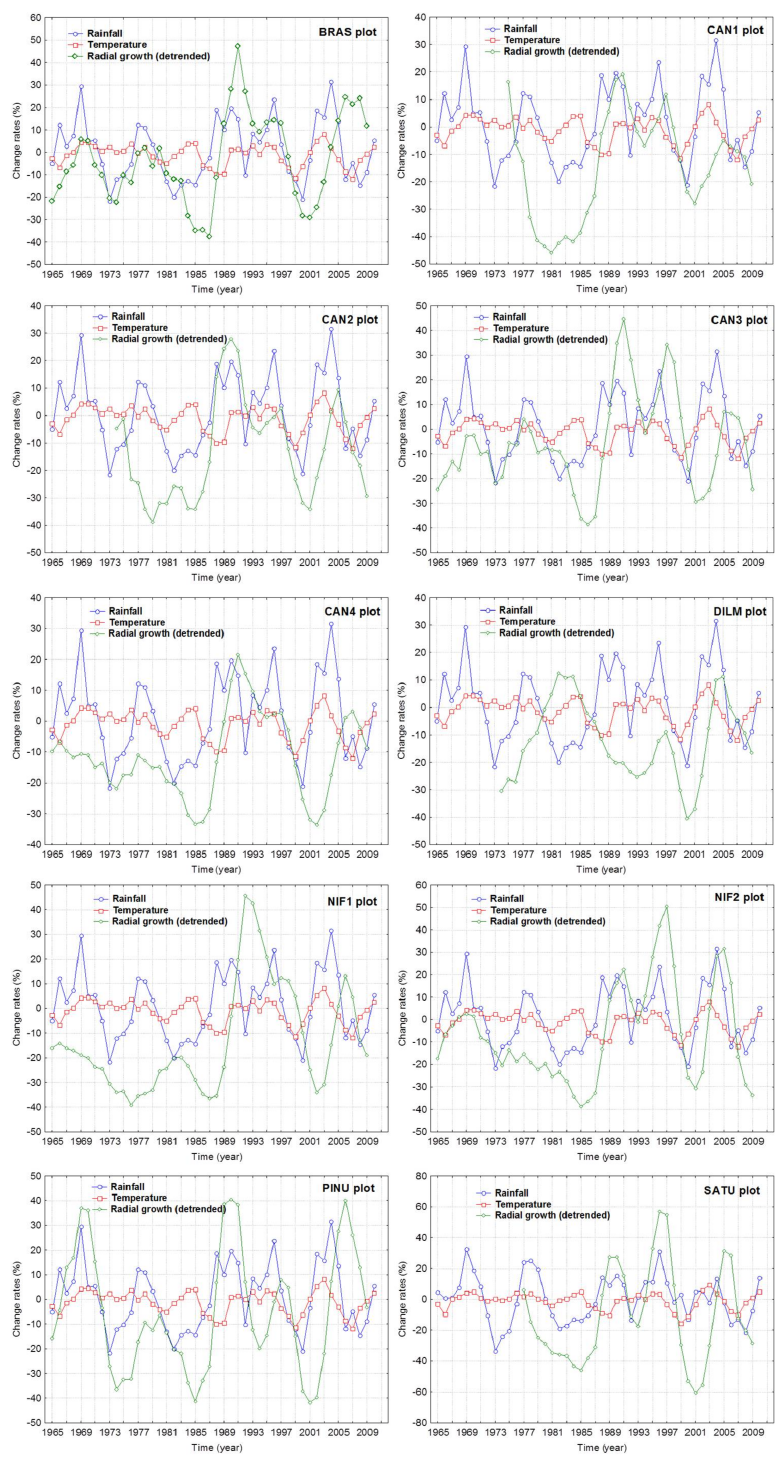
Figure 6. The dynamic of the change rates of detrended ring width, temperatures, and rainfall in the examined sample